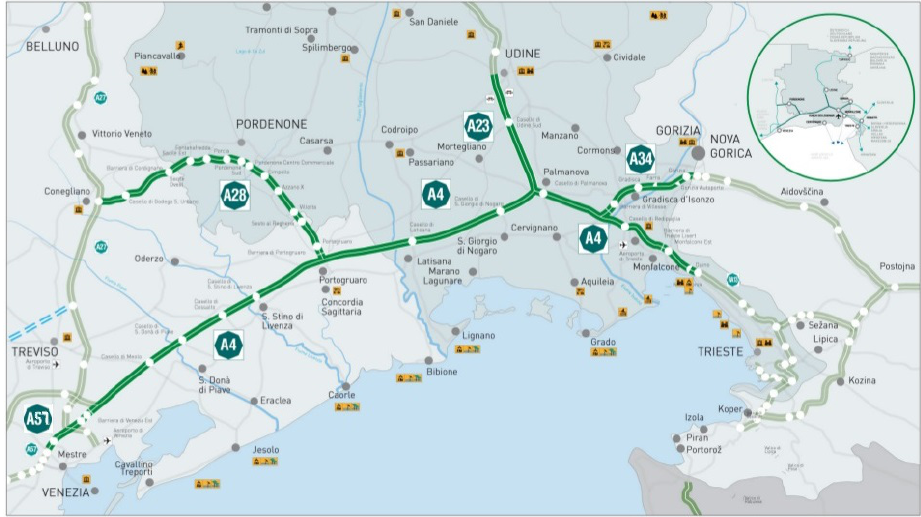
Figure 1. The Italian motorway A4 Trieste–Venice and its branches to/from Udine, Pordenone and Gorizia, managed by Autovie Venete